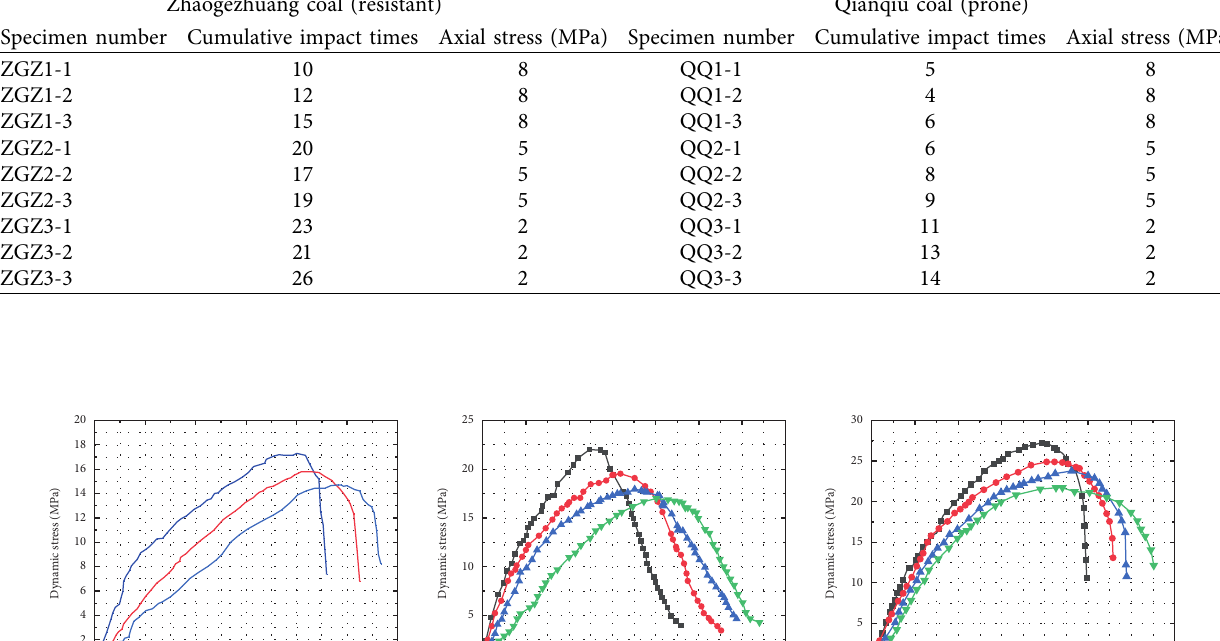
Table 6: Statistical cumulative number of cyclic impacts. Zhaogezhuang coal (resistant) Qianqiu coal (prone)